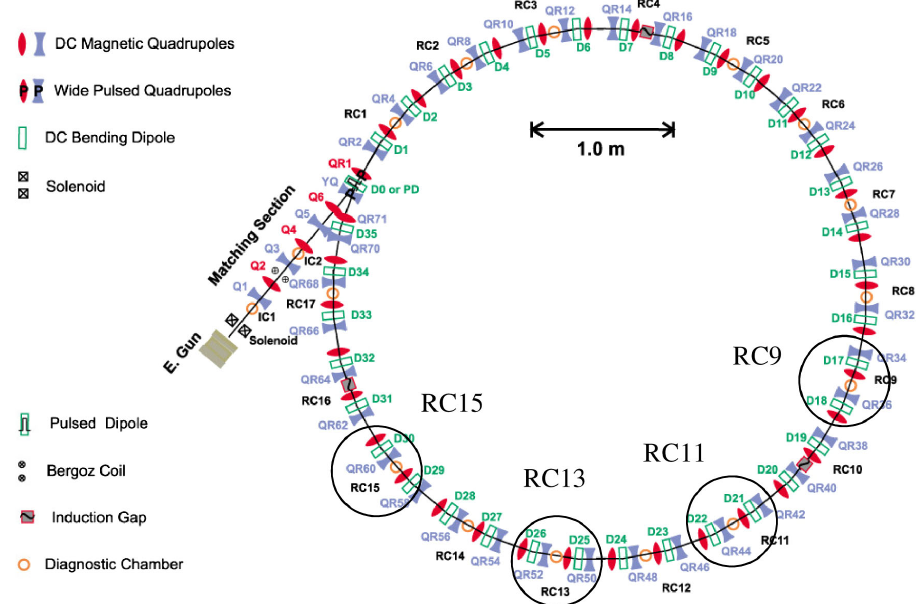
FIG. 2. Lattice optics diagram with RC9, RC11, RC13, and RC15